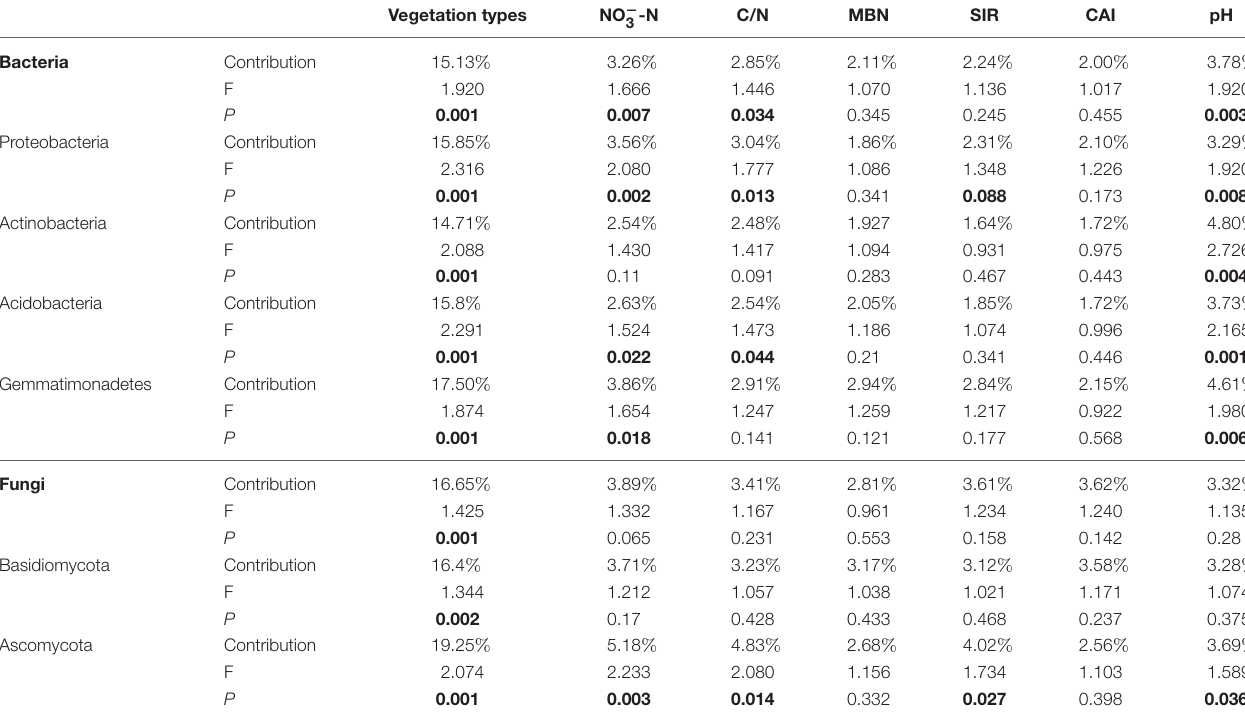
TABLE 2 | Partial CCA (canonical correspondence analysis) of the relationship between vegetation types and BIO-ENV selected soil parameters and microbial community